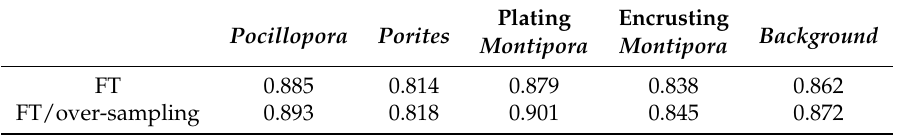
Table 6. Annotation overlap (express as IoU) between GT and prediction on the FLI-1 test area, Figure 6. In this ortho, Poisson-disk sampling succeeds in improving the segmentation of all the classes.